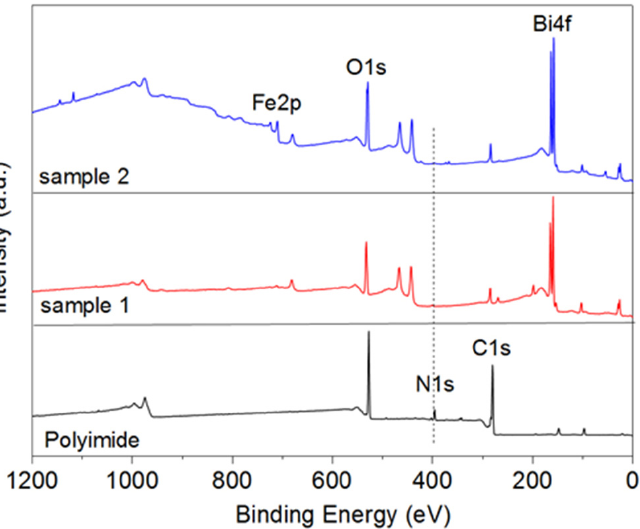
Figure 3. XPS spectrum of BFO/polyimide samples. The spectra of a clean substrate are shown, as well as how the spectrum changes at different thicknesses.